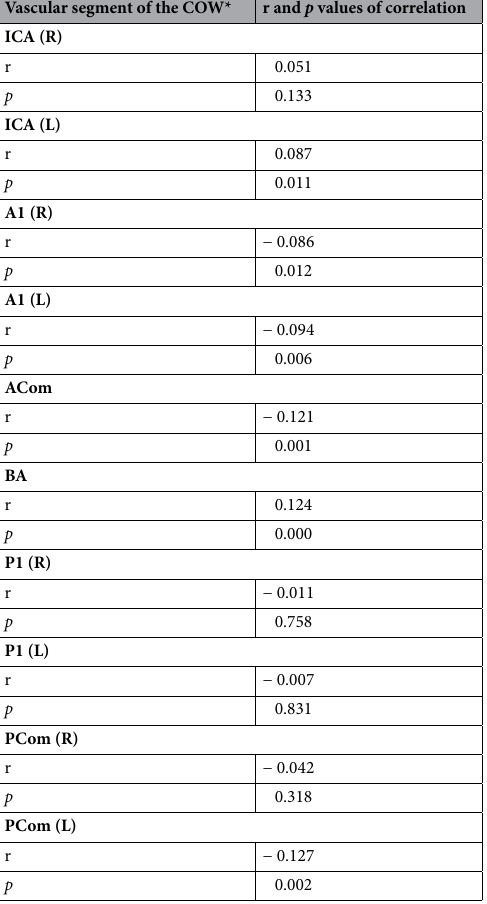
Table 5. Correlation between vessel diameter and age. *Circle of Willis, r correlation coefficient.